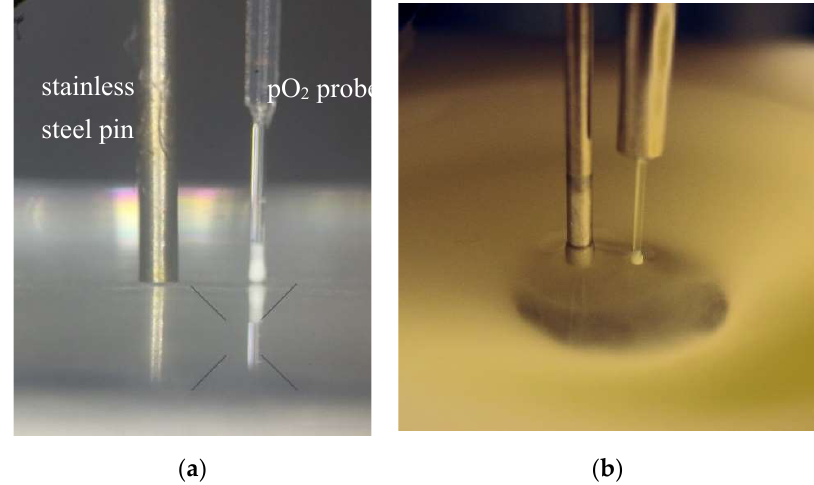
Figure A2. Exemplary optical zeroing of the oxygen probe on a plane glass surface. A microscope was used to verify the position of the oxygen probe and the aluminum bolt which was used to zero the micromanipulator device shown ( a ). Picture of the oxygen probe which was incorporated into the hydrogel to measure oxygen saturation in different gel depths ( b ).